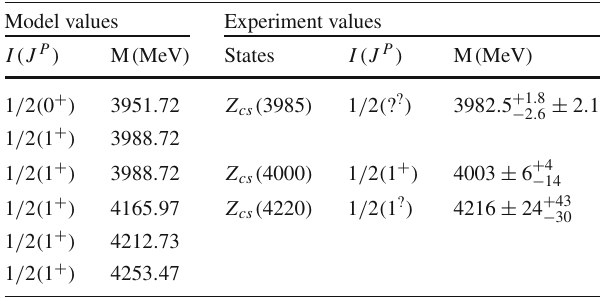
Fourth, fifth and sixth columns collect the experimental data of Z cs states, and first two columns collect the model results in which model masses are close to the experimental